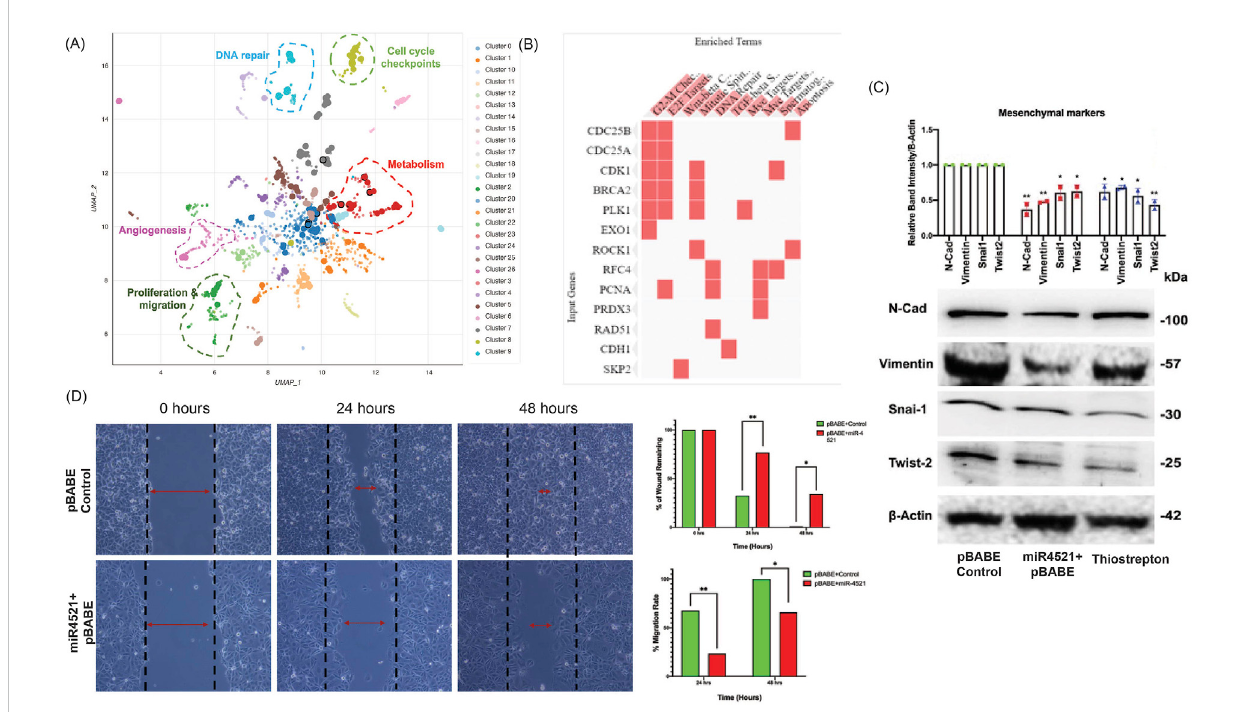
FIGURE 4 miR-4521 expression inhibits FOXM1 mediated cancer cell migration and mesenchymal gene expression in breast cancer (A-B) RNA seq was performed to identify the expression pattern of FOXM1 regulated genes involved in cell cycle, replication, proliferation, invasion, migration, angiogenesis DNA repair and metabolism in miR-4521 overexpression breast cancer cells. Bokeh plot graph using Enrichr tool showing the downregulated gene enrichment pattern upon miR-4521 overexpression in breast cancer clustered based on Uniform Manifold Approximation and Projection (UMAP). (C) Western blot analysis of mesenchymal gene expression showed downregulation of N-Cadherin, Vimentin, Twist2, and Snail in miR-4521 overexpressing cells and FOXM1 inhibitor thiostrepton treated breast cancer cells. Densitometric analysis was performed for all the western blots upon normalizing respective test protein bands to β -Actin bands; paired Student ’ s t -test (two-tailed) was performed between control, miR-4521 overexpressingMCF-7cellsandFOXM1inhibitorthiostreptontreatedcells,* p < 0.05,** p < 0.001,( n =3). (D) Cellmigrationwasmeasuredusingwound- healing assay in MCF-7 breast cancer cells overexpressing miR-4521 and control cells. miR-4521 overexpression facilitates a slower migration rate in miR-4521 overexpressing cells when compared to control cells, * p < 0.05, ** p < 0.001, ( n =